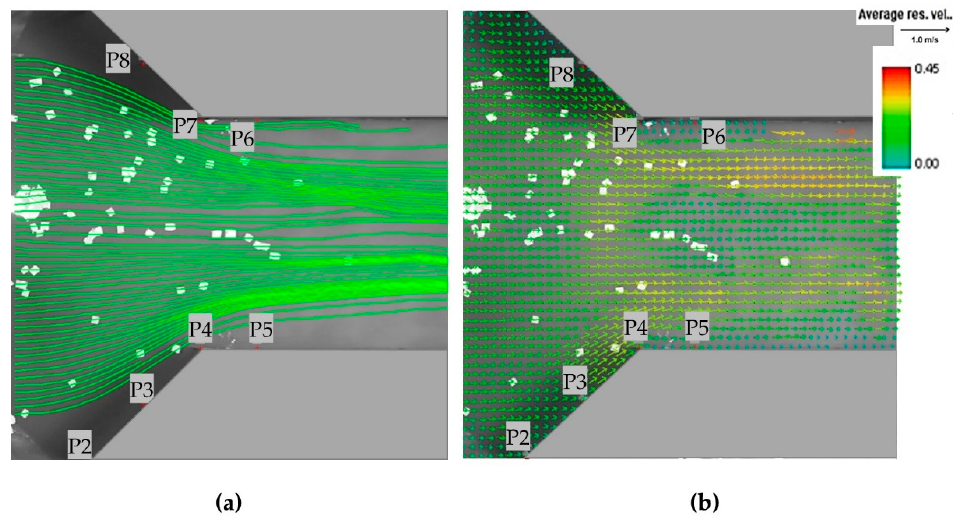
Figure 14. ( a ) streamlines and ( b ) velocity vectors for B 2 /B 1 = 0.5 and Q = 0.23 m 3 /s.